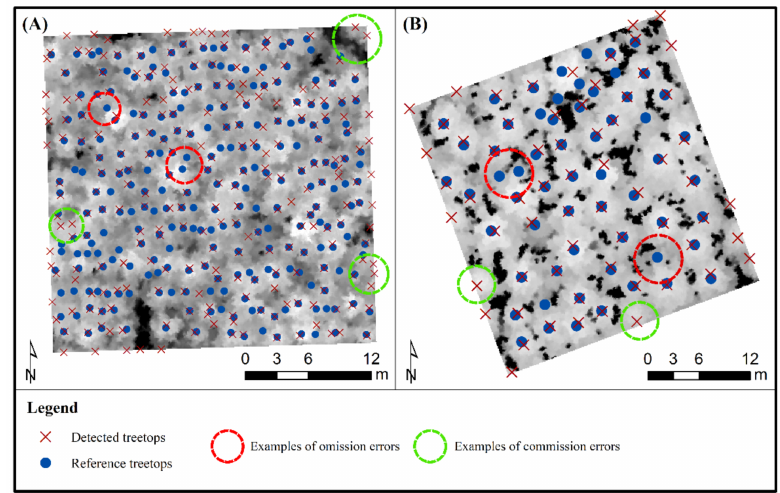
Figure 3. Examples of tree-to-tree matching. ( A ) Young forests with a stand density of about 3000 stems/ha; ( B ) mature forests with a stand density of about 700